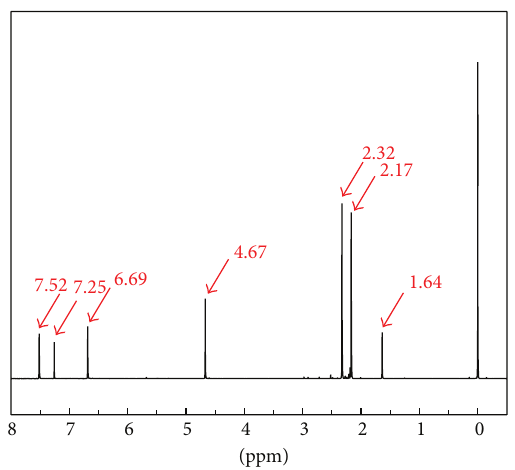
Figure 2: 1 H NMR spectrum of 4-iodo-2,5-dimethylphenol. Table 1: Major bands found in the FTIR spectrum of 4-iodo-2,5-